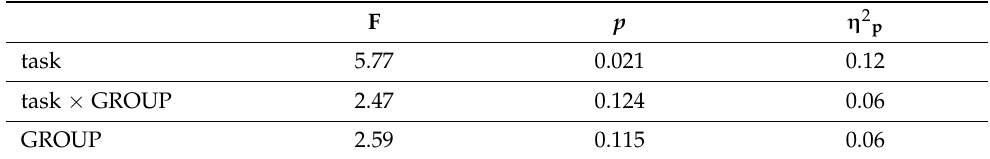
Table 4. Descriptive statistics of the studied COP and coherence parameters in both study groups.